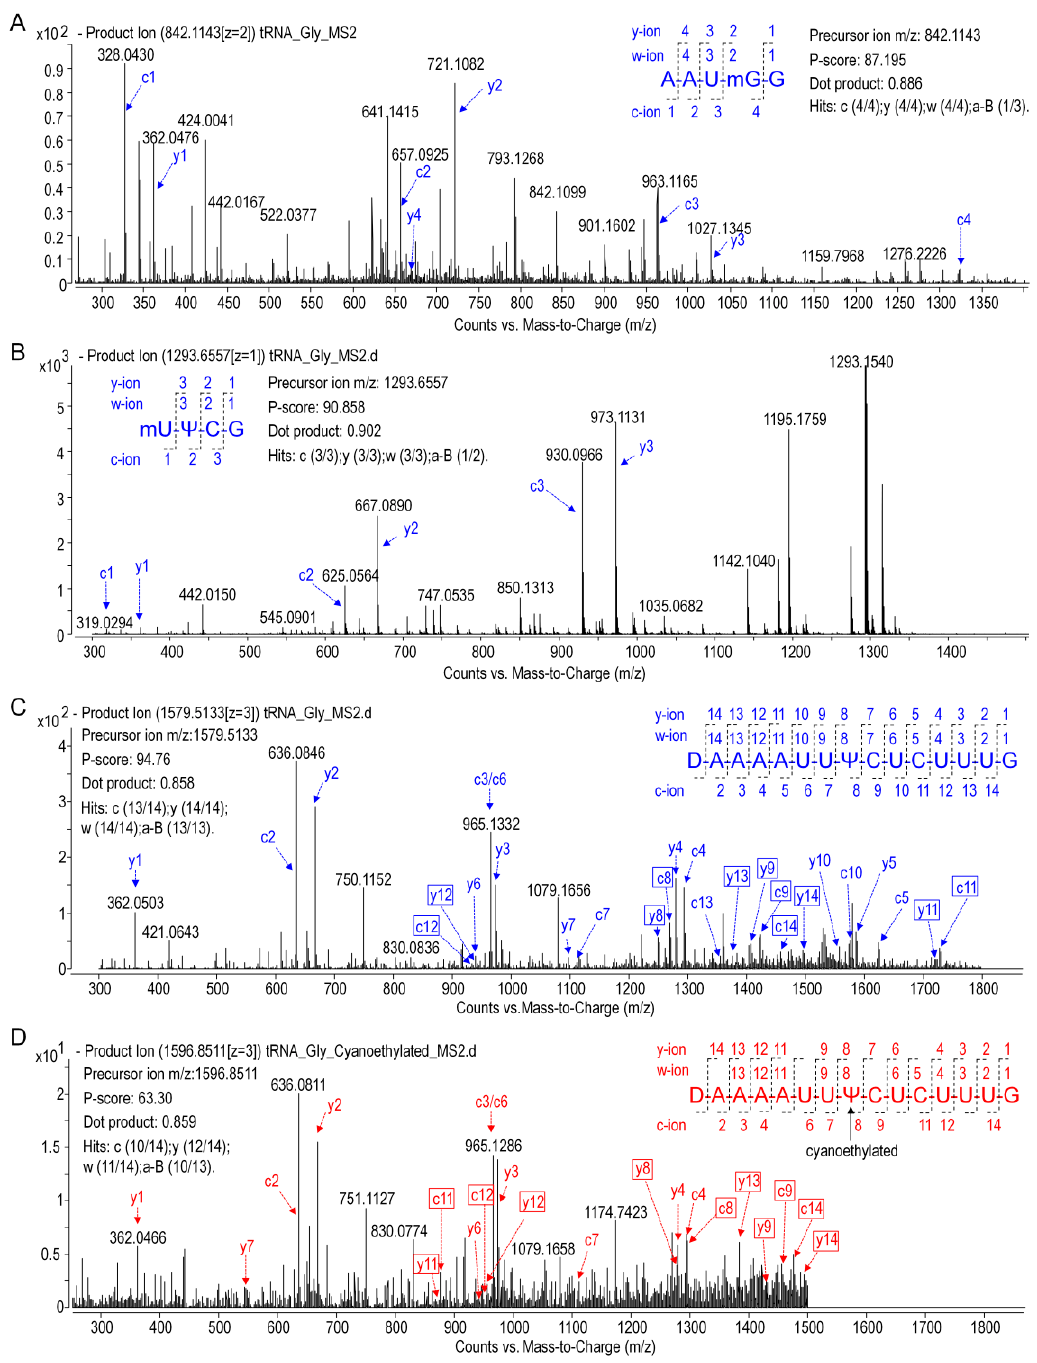
Figure 7. CID mass spectra of digestion products with precursor m / z 842.1143 ( A ), 646.0732 ( B ), and 1579.5131 ( C ). ( D ) CID spectra of cyanoethylated product with precursor m / z 1596.8511. Product ions are properly assigned and scored by RAMM program and the representative c and y ions are labeled and plotted. Unique product ions of both cyanoethylated and uncyanoethylated products are highlighted in boxes.